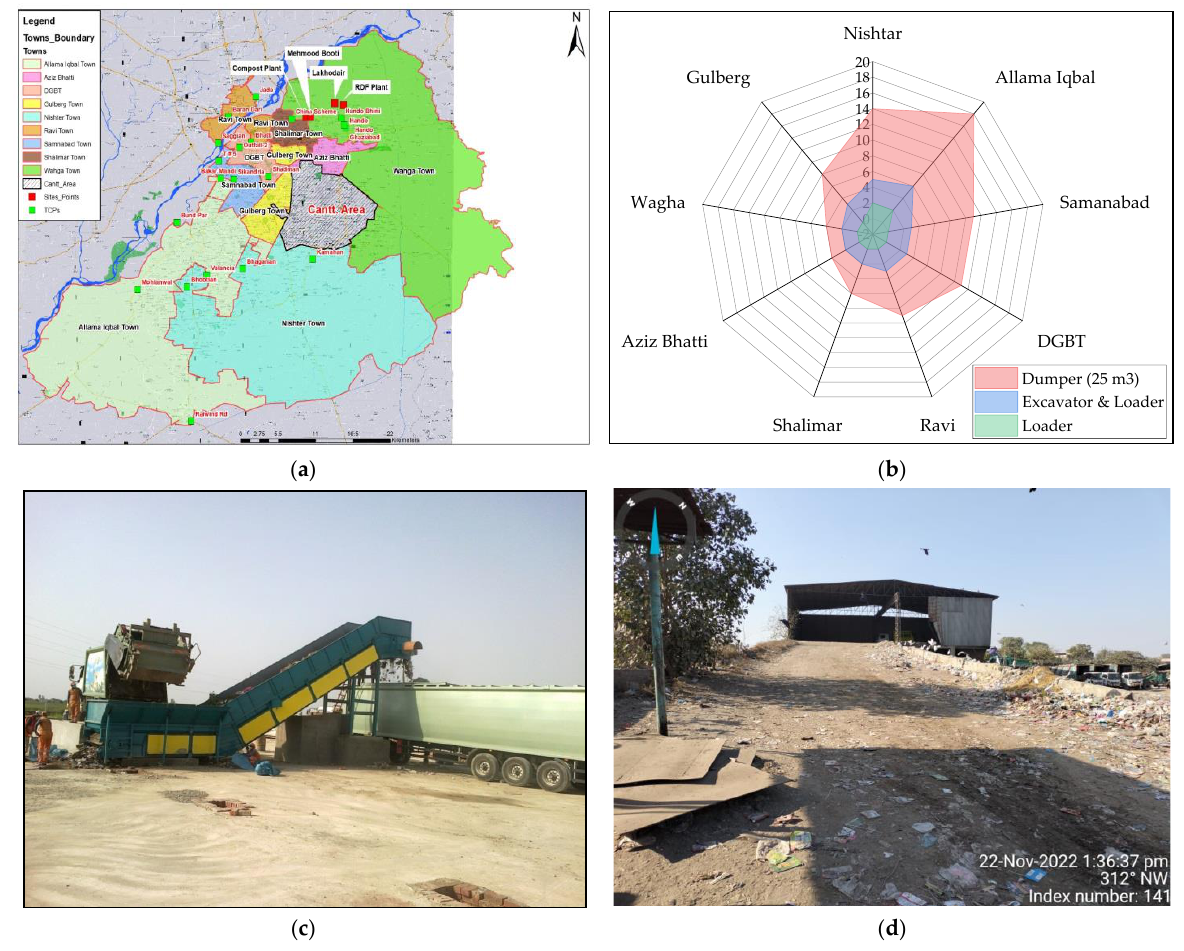
Figure 11. Secondary waste collection arrangements: ( a ) Map of Lahore showing towns and location of TCPs; ( b ) Town-wise resources deployed for secondary waste collection (locally outsourced function); ( c ) TS for secondary collection at Valencia; ( d ) TS at Saggian site.